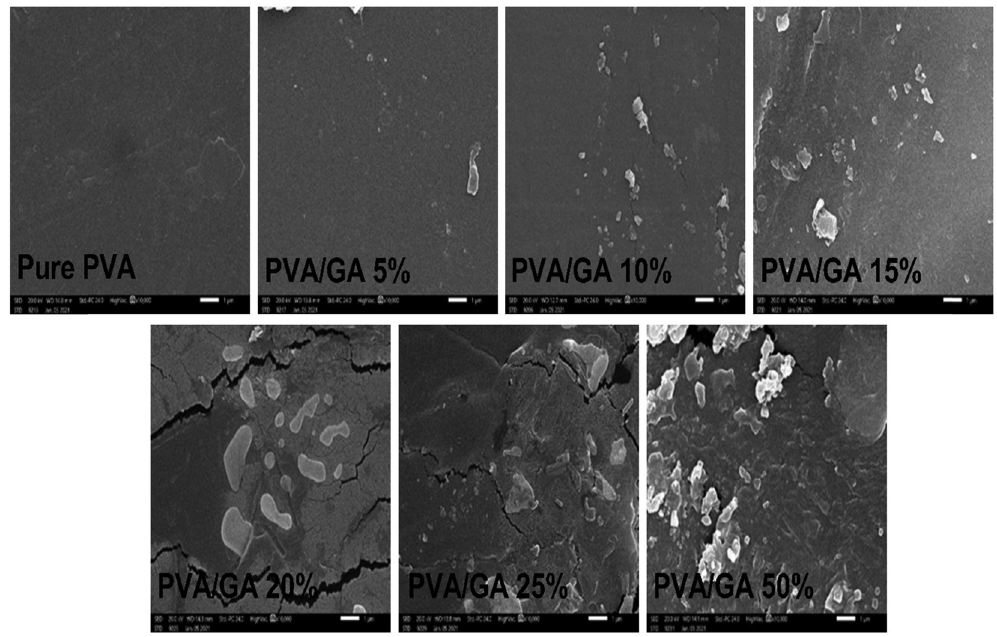
Figure 3: Scanning electron micrographs ( x = 10,000, and the scale bar is 1 µm ) of the pure PVA and the PVA/GA x hydrogels. Concentrations ( x ) of GA are from 5% to 50%.